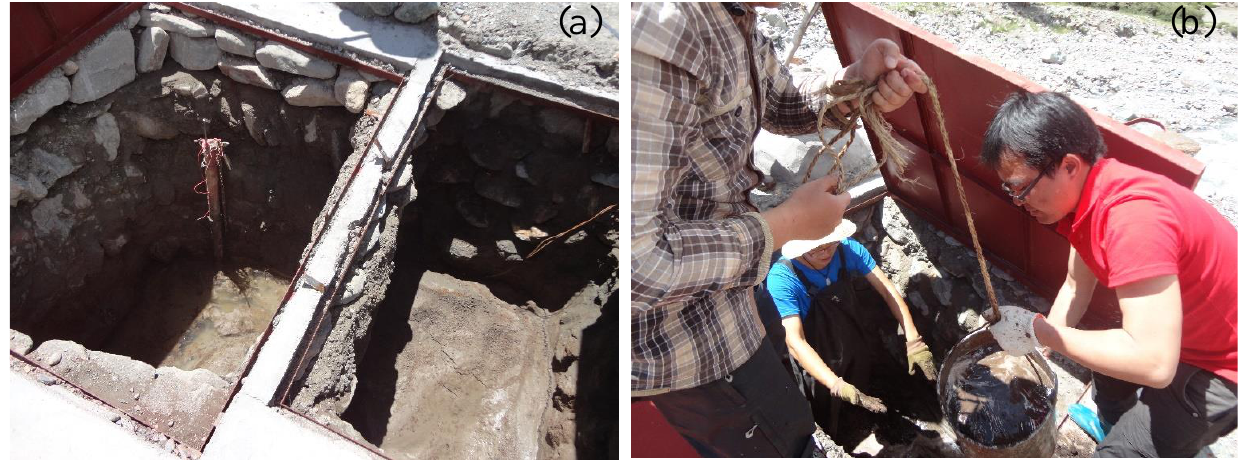
Figure 3. Two wells constructed of the hydrographic cross-section. ( a ) The silted-up wells. ( b ) Manual dredging from the water wells.